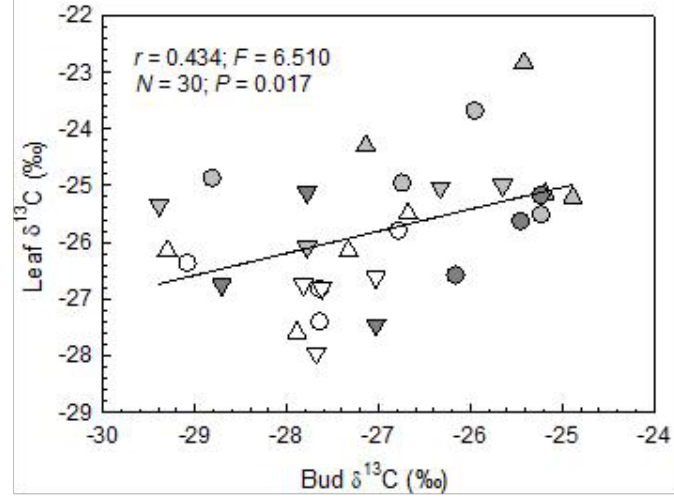
Figure 3. Leaf vs. bud δ 13 C in European beech saplings of different tree damage classes (DC; white symbols = DC1, almost no damage; light grey symbols = DC2, moderate damage; dark grey symbols = DC3, severe damage) and in different crown parts (triangles up, upper part; circles, middle part; triangles down, lower part). Table 3. Leaf features of European beech saplings (5 leaves per tree and crown part) of different damage classes (DC) in spring after a year of severe drought stress (mean values 1 SE). Capital letters refer to statistical comparisons among DC; lower-case letters indicate significant differences among crown regions. Values marked with the same letter are not significantly different. n.d.—no data available.